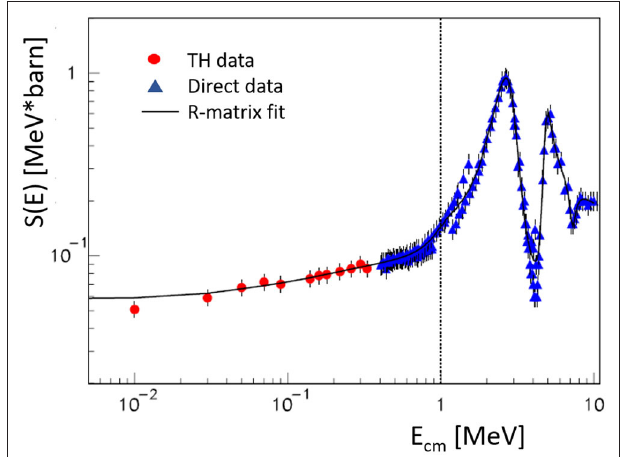
FIGURE 3 | Bare nucleus S(E)-factor for the 3 He(d,p) 4 He process obtained with direct data (blue filled triangles) and with the THM (red filled dots) taken from La Cognata et al. (2005). Full description is reported in the text. The figure is adapted from Pizzone et al. (2014).